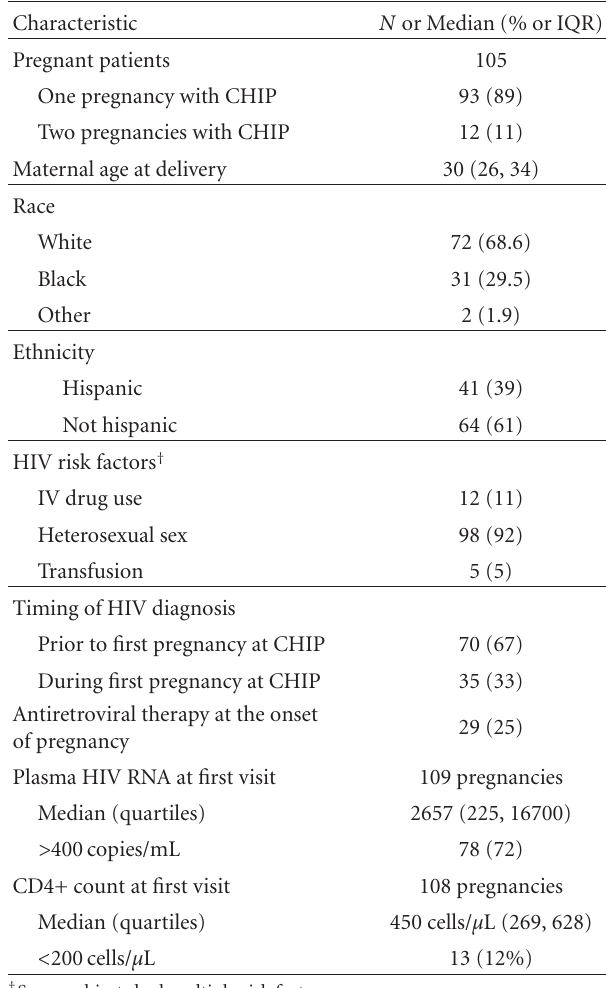
Table 1: Demographics and baseline characteristics of HIV infec-